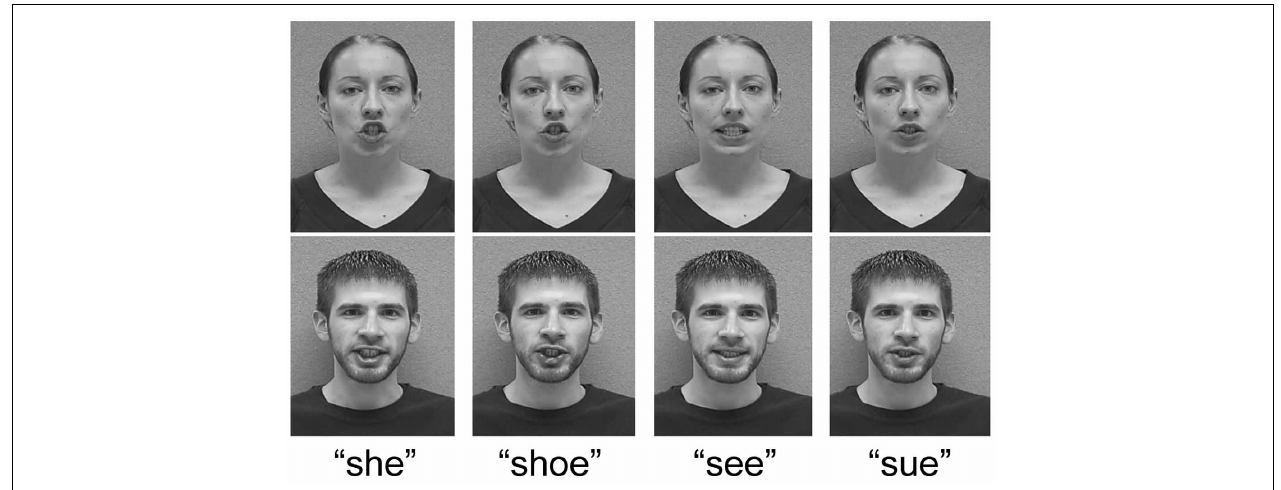
FIGURE 3 | Example frames from the videos used in Experiment 2, cropped to highlight the talkers’ faces. Images were taken from portions of videos during consonant articulation. Lip rounding coarticulation is visible for all consonants in the context of the /u/ vowel.